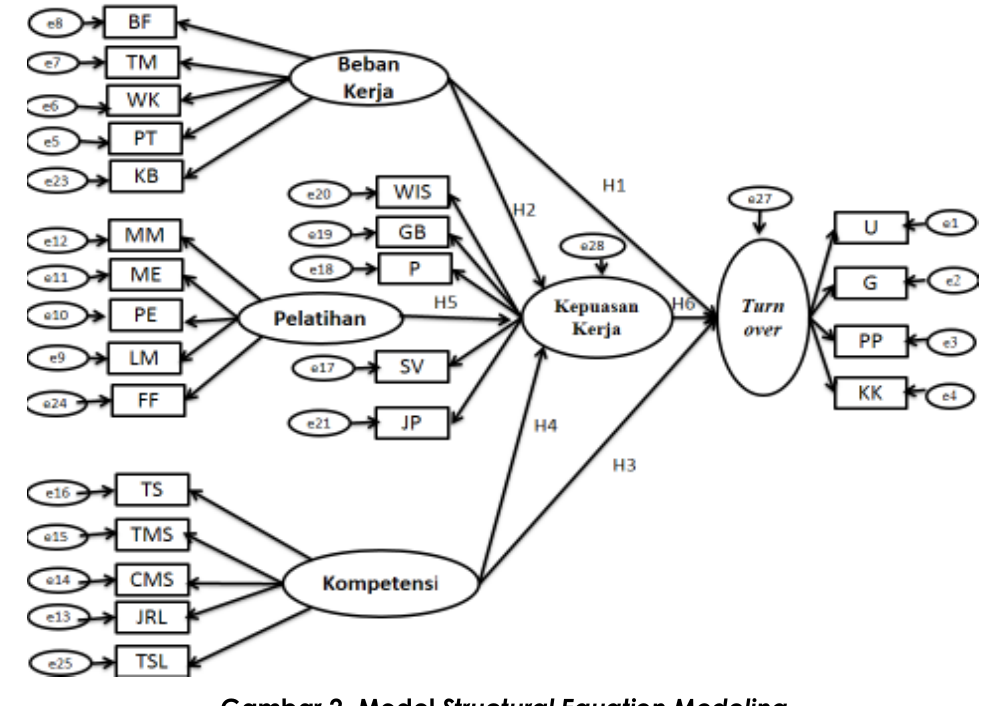
Gambar 2. Model Structural Equation